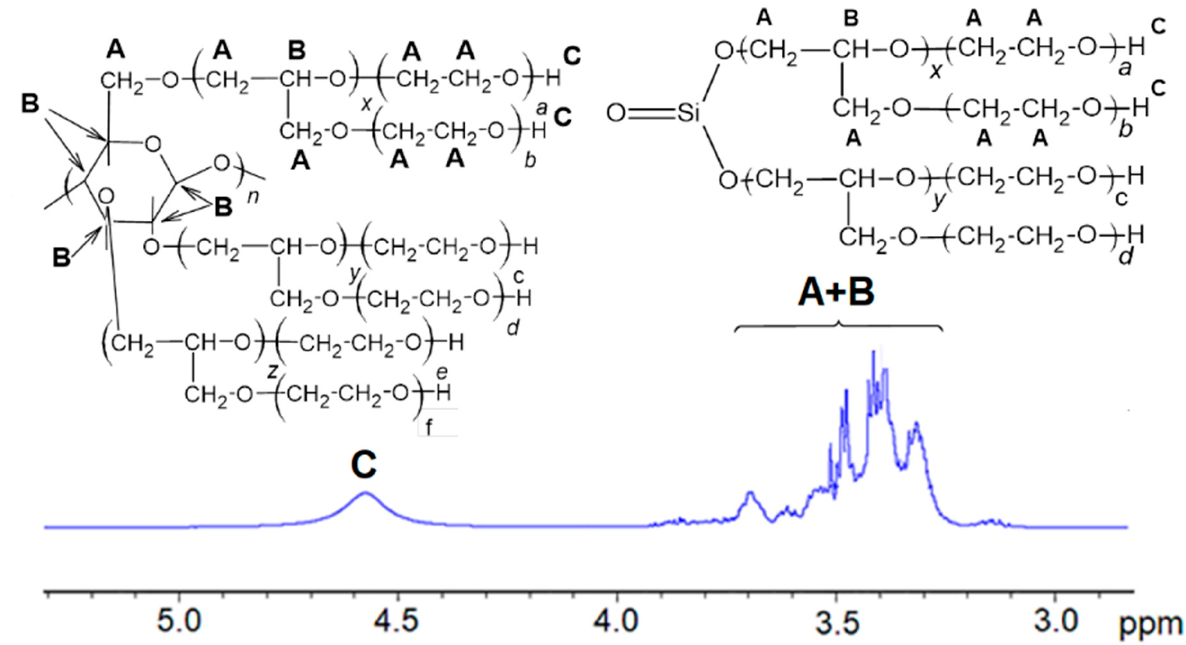
Figure 2. 1 H-NMR spectrum of polyol.